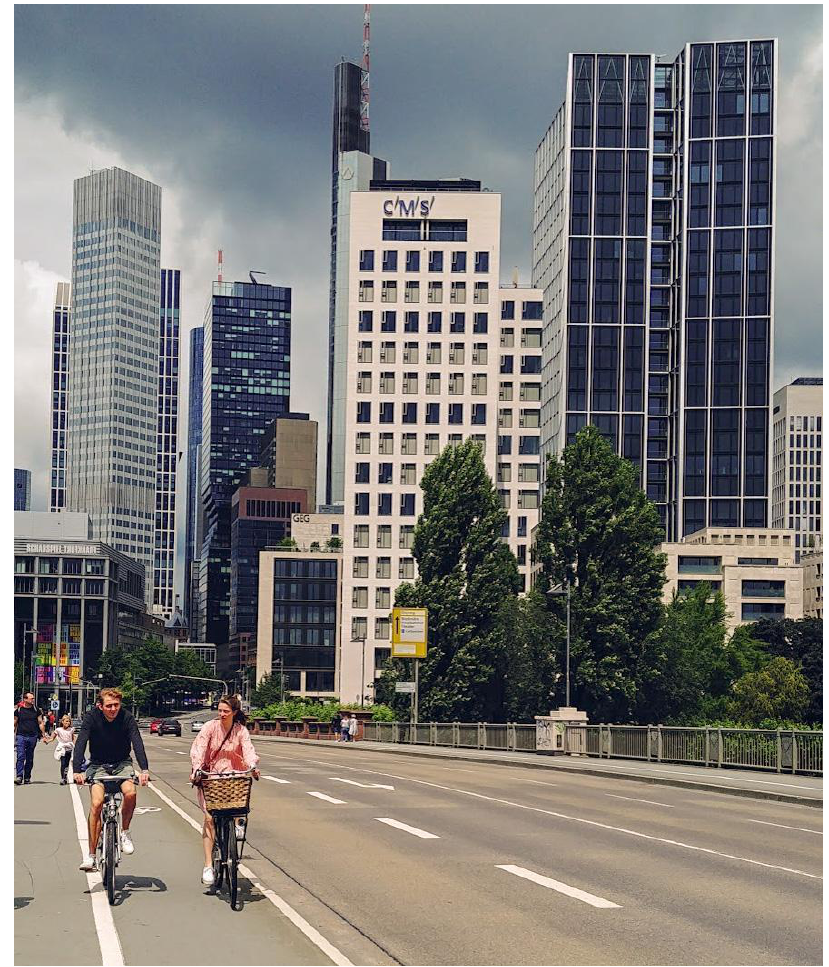
Figure 4. Cyclists on a separated bike lane on the Untermainbrücke crossing the Main River leaving downtown with its skyscrapers (Photo: Ralph Buehler) . Overall, bicycling promotion in Frankfurt until 2019 had been successful, reaching 20% of all trips. The city has designated almost 1400 km of bicycle routes in the city, in- cluding cycling on roadways and separate cycling infrastructure. The city has opened over 90% of all one-way streets for two-directional bicycle traffic. Moreover, the city already has traffic calmed 52% of all its roadways to 30 km/h or less and has strictly reduced au- tomobile parking in the city center [19]. The year 2019 was a significant turning point for cycling in Frankfurt. The three gov- erning parties of the city agreed on a new bicycle policy called Fahrradstadt Frankfurt (Bi- cycle City Frankfurt) [30]. This was in response to a grass-roots bicycling initiative that collected more than 40,000 signatures to pressure the city government to promote bicy- cling. The main component of the new plan is to install 45 km of new separated bike lanes by 2023. The protected bike lanes are to be a minimum of 2.30 m (7.5 feet) wide and phys- ically separated from motorized traffic. In addition, 15 major intersections are to be rede- signed by 2022 to better accommodate cyclists through infrastructure measures and signal timing. The city intends to connect express bikeways from the hinterlands through the